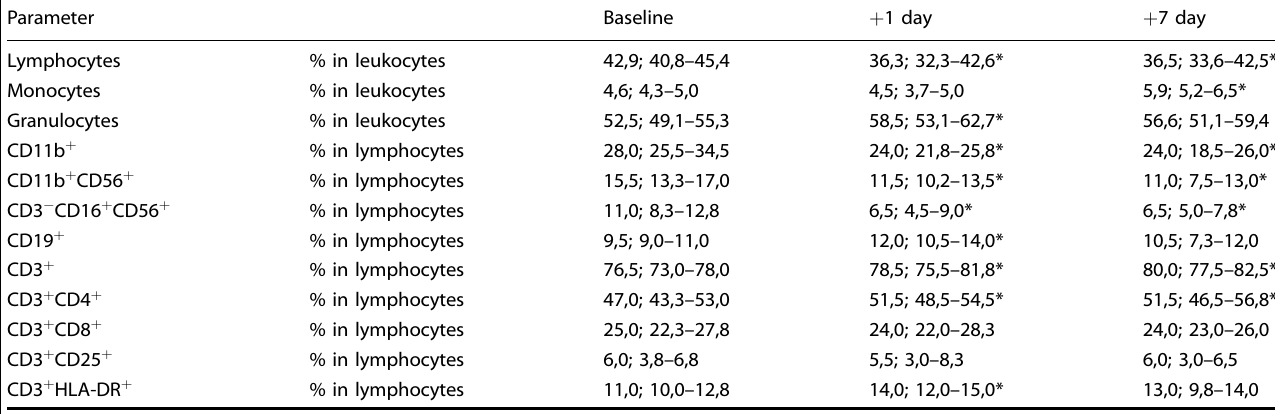
Table 1. Peripheral leukocyte subset in the dynamics of pre- and post fl ight examinations of cosmonauts (median; q25 – q75), p values were obtained using the Wilcoxon ’ s